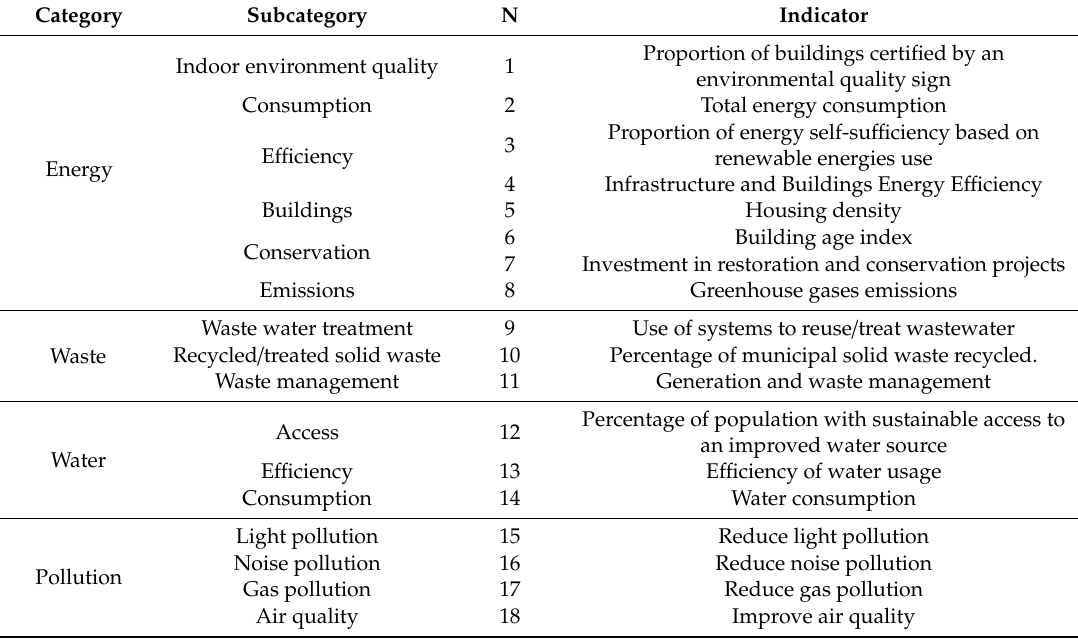
Table 3. Proposed indicators for environmental aspects (resources